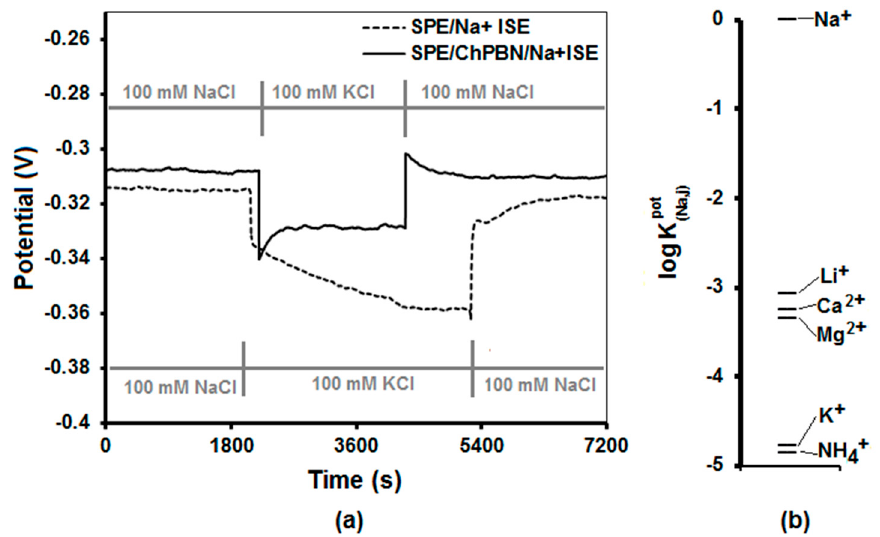
Figure 8. Water layer test and selectivity test of SPE/ChPBN/Na + ISE: ( a ) Water layer tests for the SPE/Na + ISE and SPE/ChPBN/Na + ISE in 0.1 M NaCl as the primary ion and 0.1 M KCl as the interfering ion; ( b ) potentiometric selectivity coefficients of SPE/ChPBN/Na + ISE. See the text for the details.